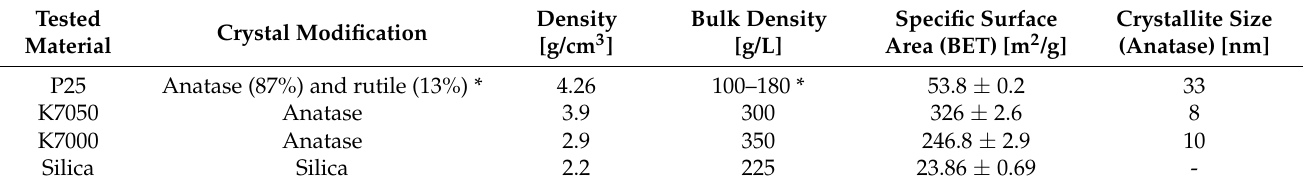
Table 1. Characteristics of the commercial TiO 2 powders and reference silica (information provided by the